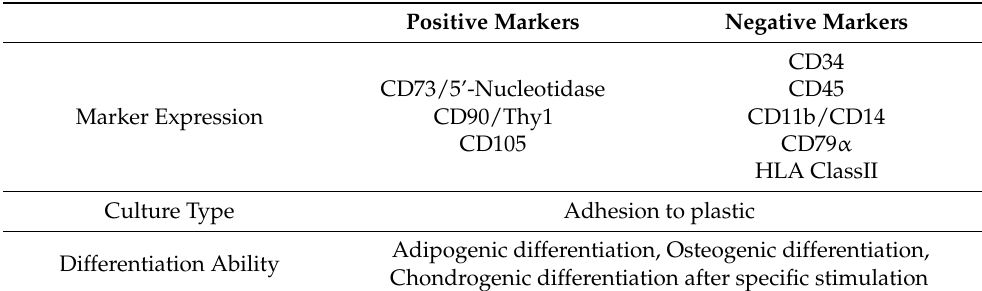
Abbreviation: ISCT, International Society of Cellular